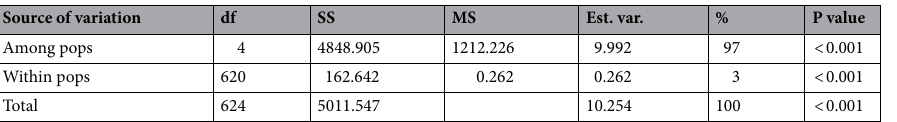
Table 1. Analysis of molecular variance (AMOVA) of 625 rice accessions based on the 36 KASP markers. df degree of freedom, SS sum of squares, MS mean squares, Est. var. estimate of variance, % percentage of total variation, P-value is based on 999